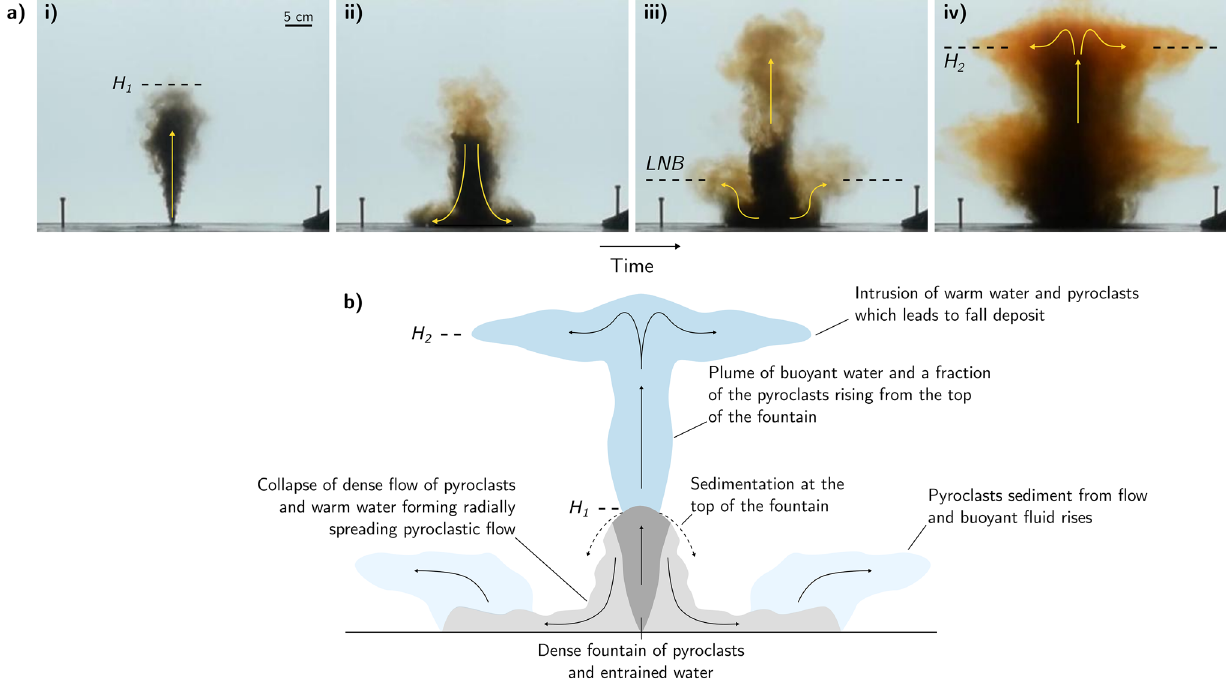
Figure 2. ( a ) Experimental images displaying the dynamics of a particle-laden fountain with positively buoyant interstitial fluid in a weak ambient stratification. The frames (i–iv) were taken at times 5 s, 10 s, 15 s and 60 s after the initial injection. Images show both the collapse of the particle-laden fountain to form a flow deposit and the rise of buoyant fluid and particles from the top of the fountain. Panel (iii) shows the formation of a lower intrusion ( LNB ) as fluid rises from the gravity current and panel (iv) shows the formation of an upper intrusion H 2 as a result of particle-fluid separation at the top of the fountain. ( b ) Schematic cartoon illustrating the primary dynamics of a deep-submarine explosive